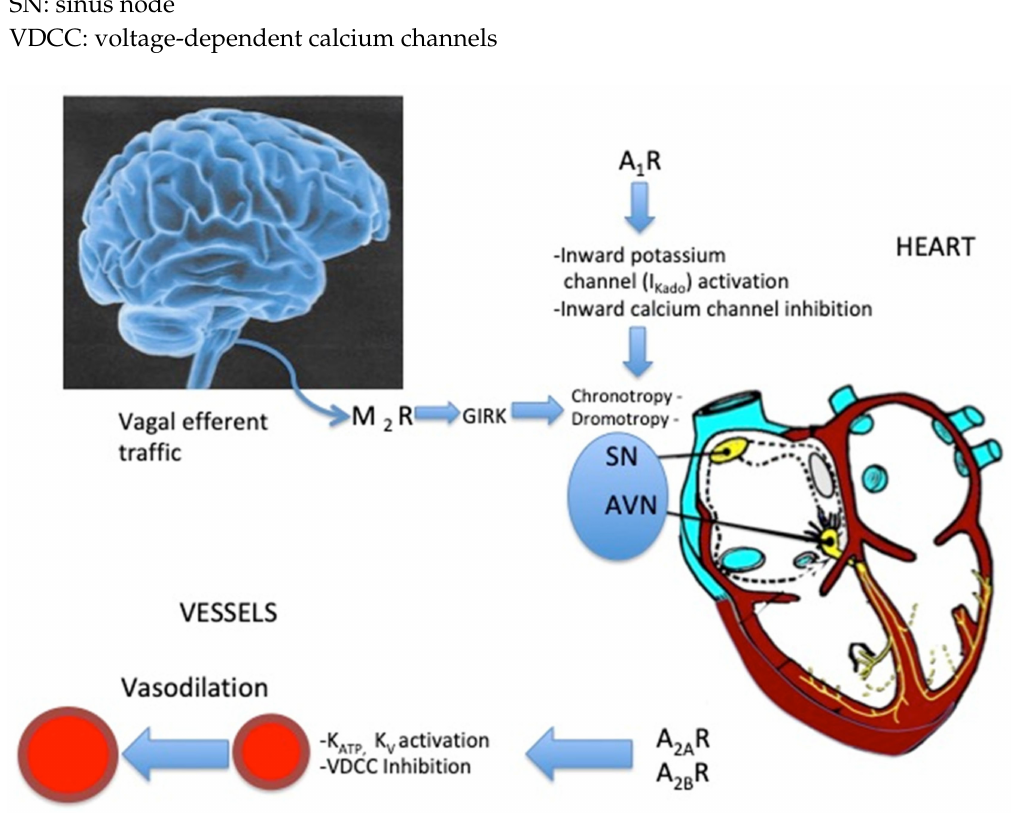
Figure 2. Schematic representation of the action of adenosine or vagal e ff erent fibers on the heart and